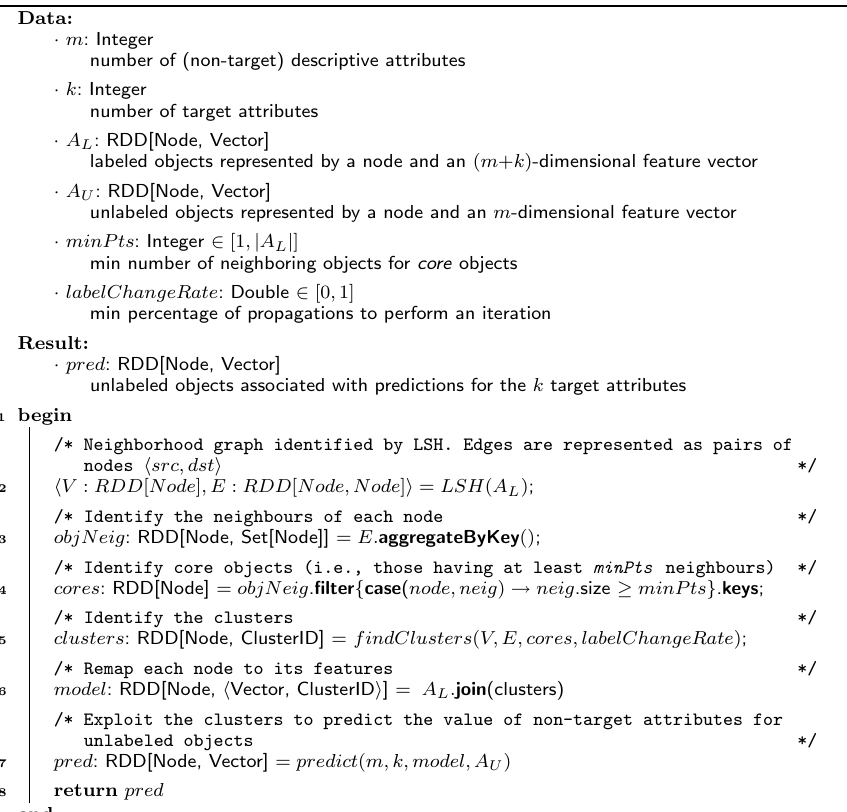
Algorithm 1: Main